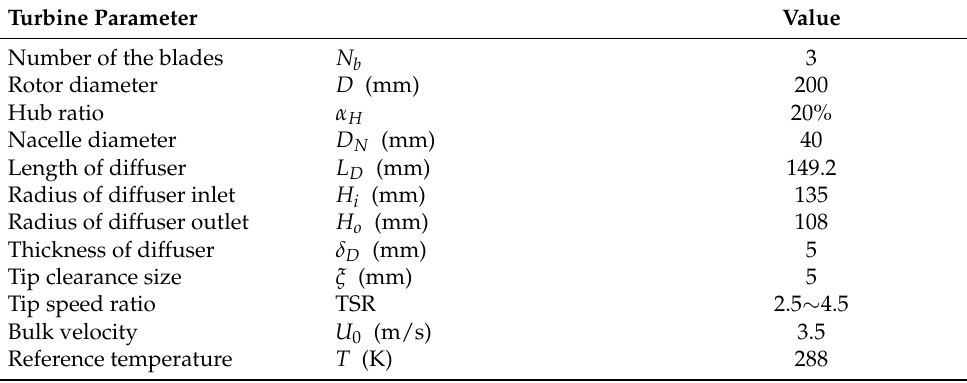
Table 2. Specifications of the